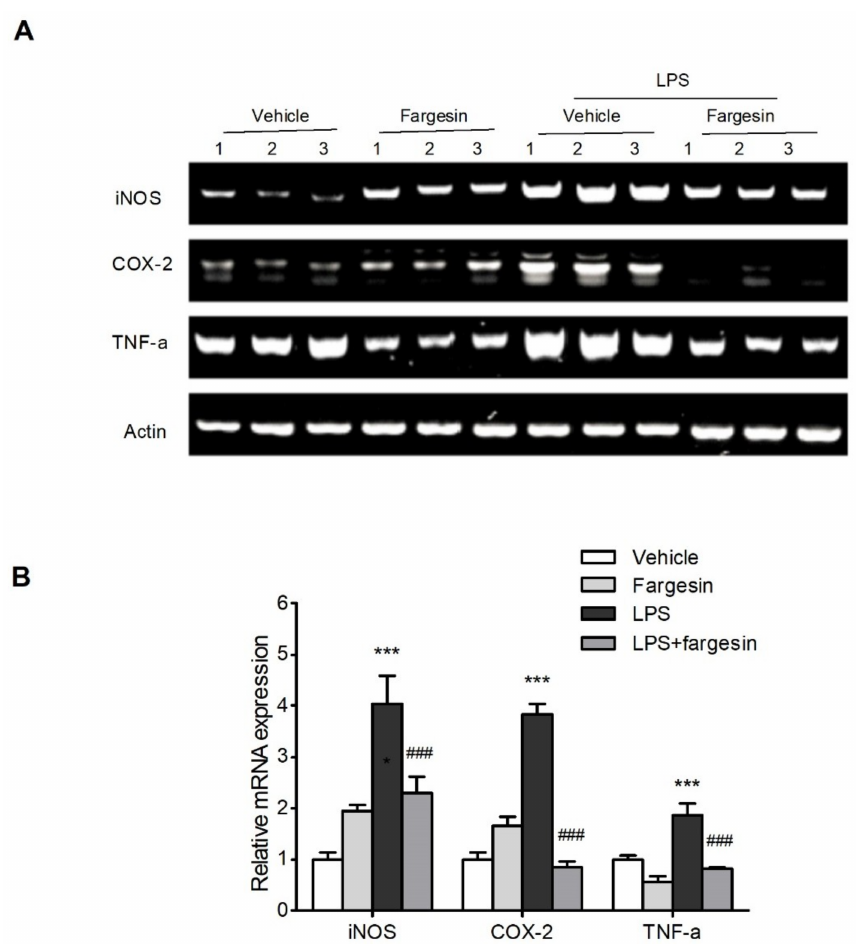
Figure 6. Fargesin downregulated the proinflammatory gene expression in vitro. ( A ) RAW264.7 cells were treated with fargesin (0, 25 µ M) for 2 h prior to LPS (2 µ g/mL) treatment for an additional 12 h. RNA was extracted as described, and the mRNA expression of proinflammatory genes was carried out by semi-qPCR. The expression was normalized to β -actin. ( B ) Quantification of the mRNA expression was performed by densitometric analysis of the bands. *** p < 0.001 vs. vehicle-treated samples; ### p < 0.001 vs. LPS-treated